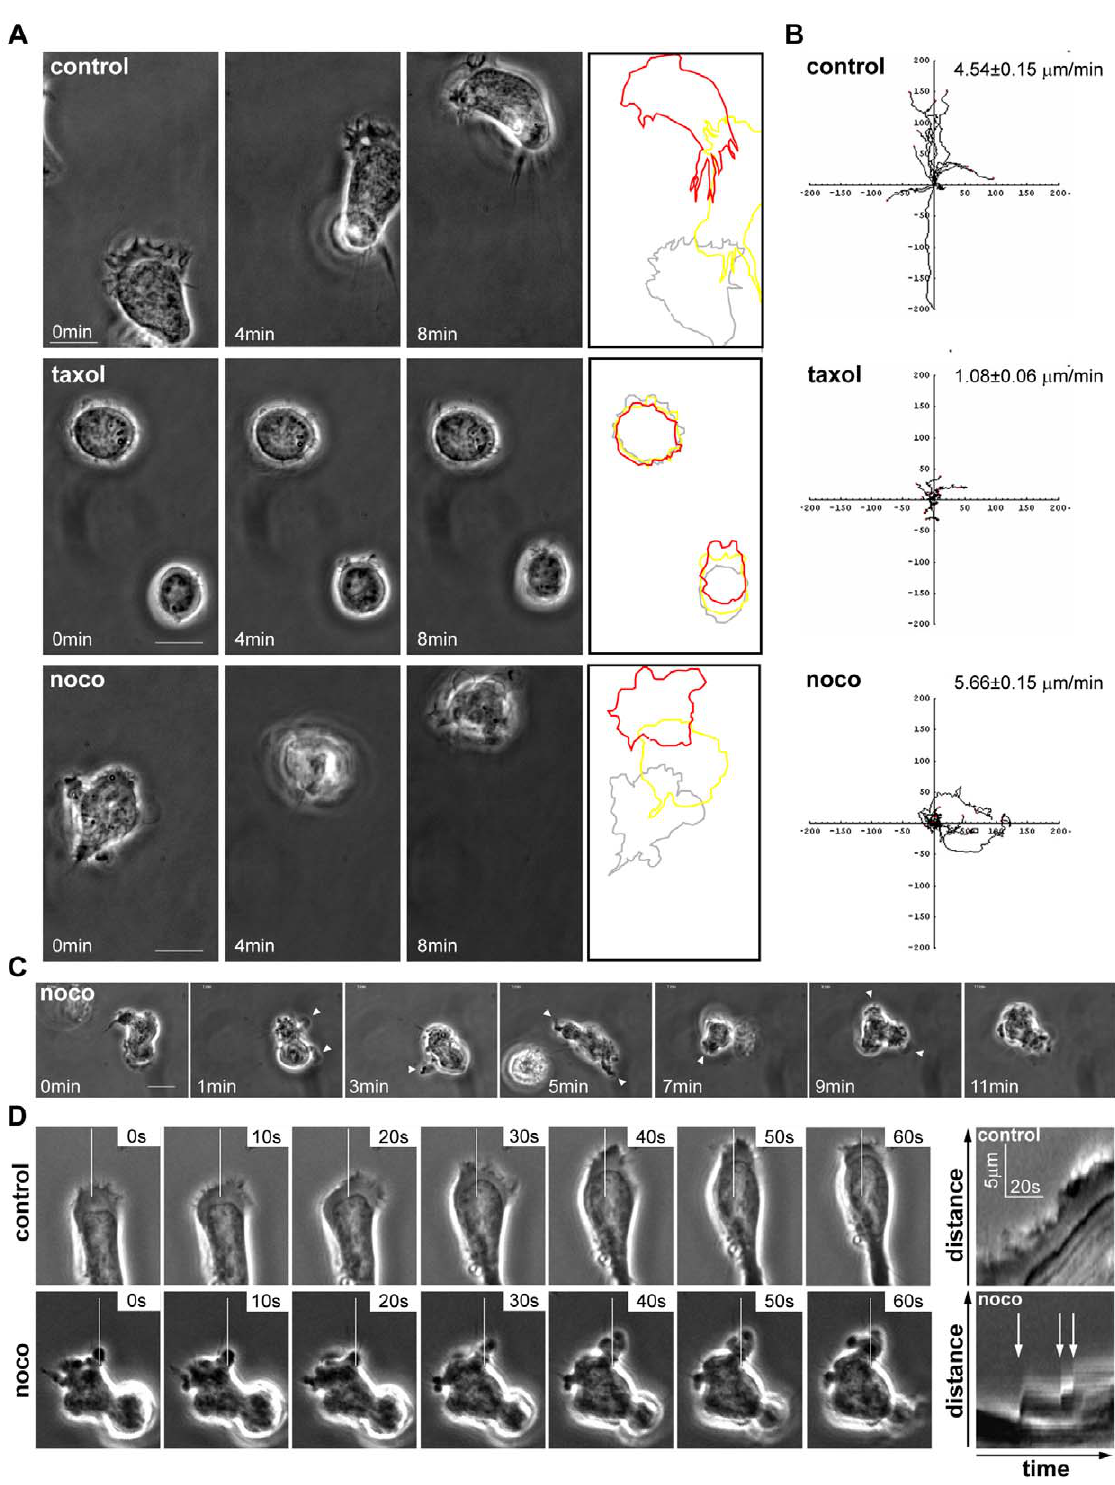
Figure 1. Microtubule dynamics are required for stable T cell migratory polarity. CCRF-CEM T cells were pre-treated with or without 10 m M taxol for 30 min or 20 m M nocodazole for 10 min, plated on ICAM-1-coated dishes, and stimulated with 1 nM CXCL12. Cell migration was monitored by time-lapse microscopy. (A) Frames from movies of control, taxol or nocodazole-treated CCRF-CEM cells at 0, 4 and 8 min are shown. Outlines of the cells at 0 (gray), 4 (yellow) and 8 (red) min reveal the migrating paths. Bars=10 m m. (B) Migration tracks of cells (10 to 16 cells for each condition) are displayed as direction plots. The mean migration speed of cells 6 SEM is shown. Data shown are representative of 4 independent experiments. (C) Frames of a nocodazole-treated CCRF-CEM cell (Movie S8). White arrowheads indicate bleb-like protrusions. (D) Frames of a control (top panels; Movie S4) and nocodazole-treated (bottom panels; Movie S5) CCRF-CEM cell are shown. Right panels show kymographs of the region marked by the white bar in the left panels. White arrows (bottom panel) indicate extension of progressive blebs. Bar=10 m m.